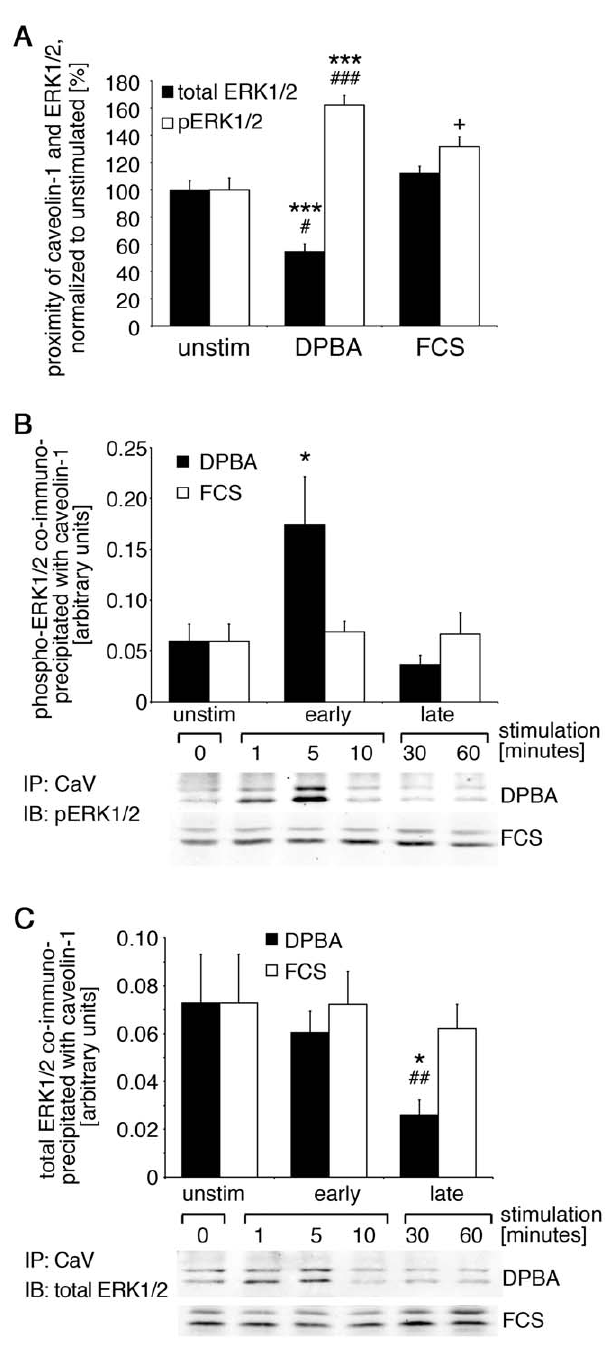
Figure 3. A caveolar fraction of ERK1/2 is phosphorylated and mobilized in a stimulus-specific manner. (A) A7r5 cells grown on coverslips were stimulated with DPBA or FCS, or left unstimulated, and then fixed and stained with a caveolin-1 antibody and either an ERK1/2 or phospho-ERK1/2 antibody. Cells were processed for proximity ligation assays (Olink) according to the manufacturer’s protocol and then analyzed for signal dots indicative of close proximity. (B and C) A7r5 cells were treated with either DPBA or FCS for the indicated times. Lysates were then subjected to immunoprecipitation with an anti- caveolin-1 antibody. Immunoprecipitates were analyzed for co-immu- noprecipitation of (B) phospho-ERK1/2 and (C) total ERK1/2 by western blotting and densitometry. Please note that interaction of caveolin-1 with phospho-ERK1/2 is increased at early time points after DPBA, but not FCS stimulation, whereas interaction with total ERK1/2 is reduced